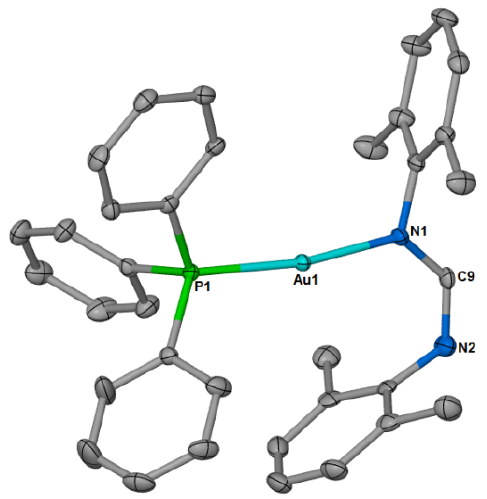
Figure 1. Thermal ellipsoid plot of 1 shown at the 50% probability level. The hydrogen atoms have been omitted for